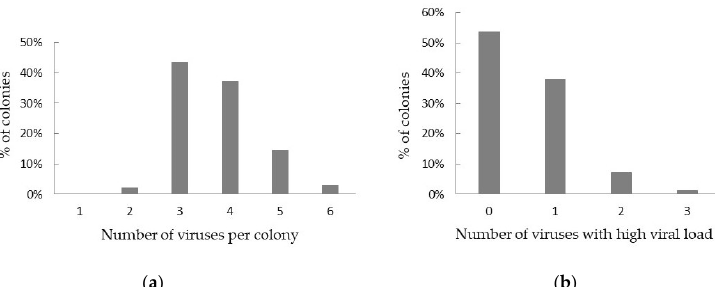
Figure 3. Viral co-infection of Belgian honey bee colonies. ( a ) Percentage of honey bee colonies infected with multiple viruses; ( b ) percentage of colonies infected with zero, one or several viruses at high viral